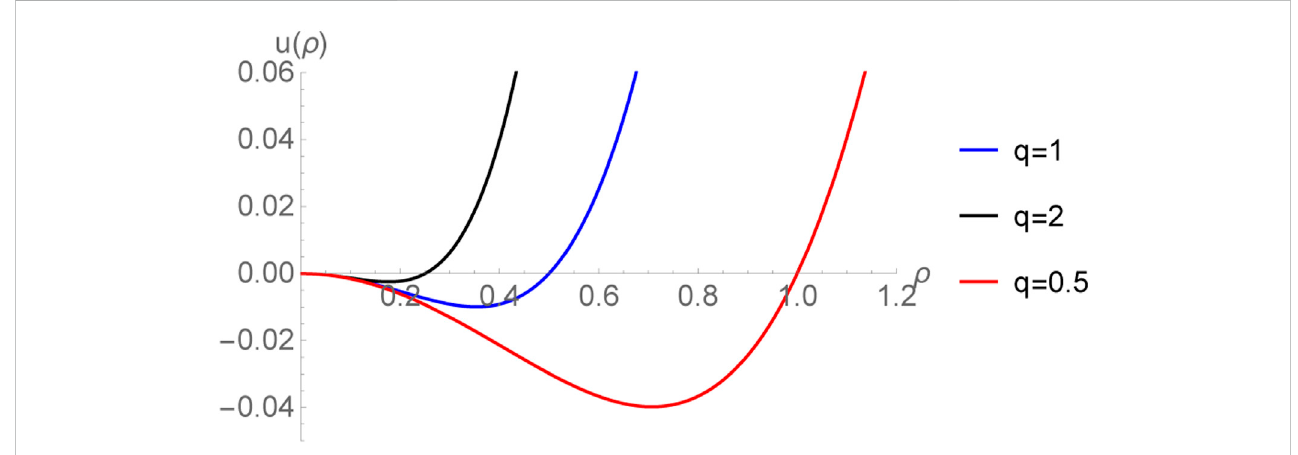
FIGURE 4 Mean fi eld potential u ( ρ ) for different values of electric charge.